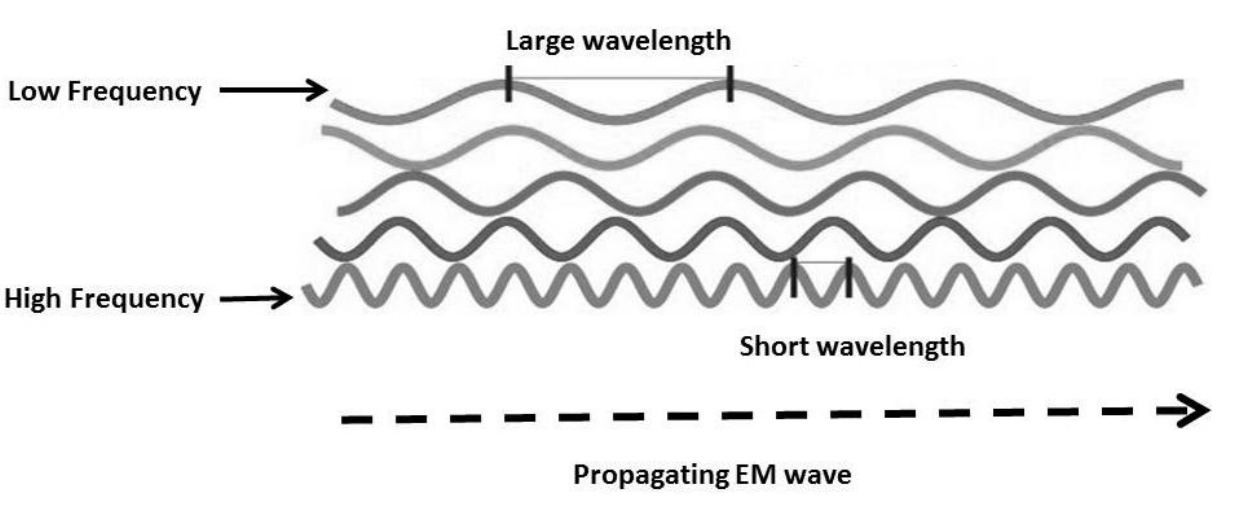
Figure 2. Propagating Electromagnetic